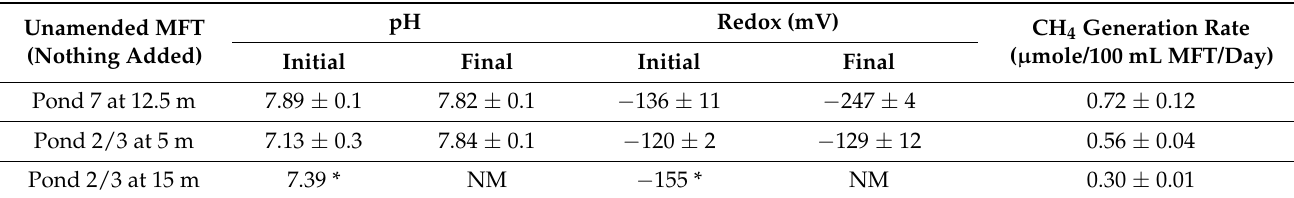
Table 2. Methanogenic rates in unamended (i.e., nothing added) MFT microcosms calculated using the data from Figure 1A. Values are the average of at least two measurements, except for *, which is a single analysis or NM (not measured). pH Redox (mV) Unamended MFT (Nothing Added) Pond 7 at 12.5